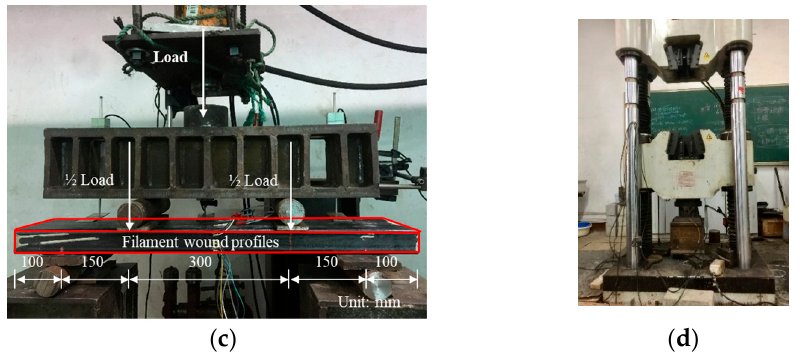
Figure 3. ( a ) Cross-section of a specimen. ( b ) The layup of CFRP. ( c ) Setup of the four-point bending test. ( d ) Compression test.